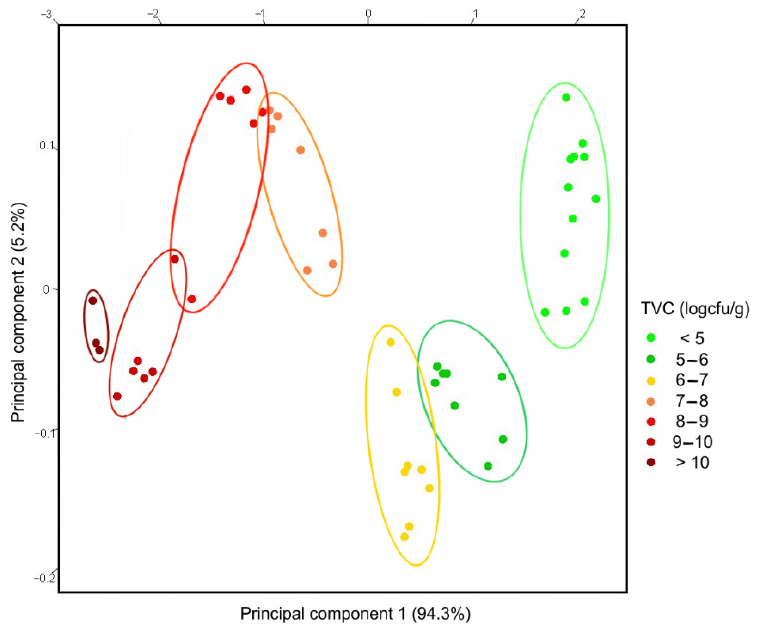
Figure 7. PCA plot of random samples of rainbow trout. The color indicates the log(TVC) with the same scale of the X-axis in Figure 6.